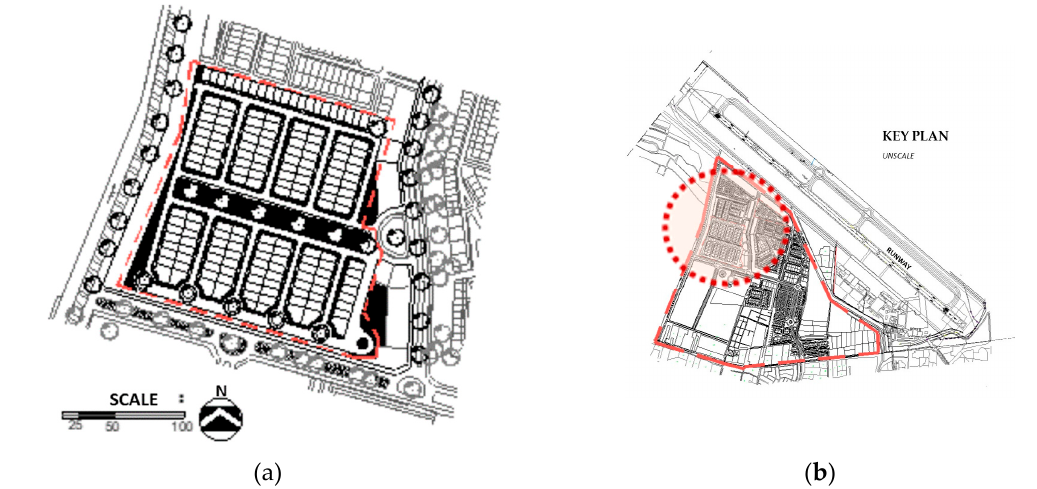
Figure 20. (a) Dwelling layout design in residence area closed to the airport; (b) Key